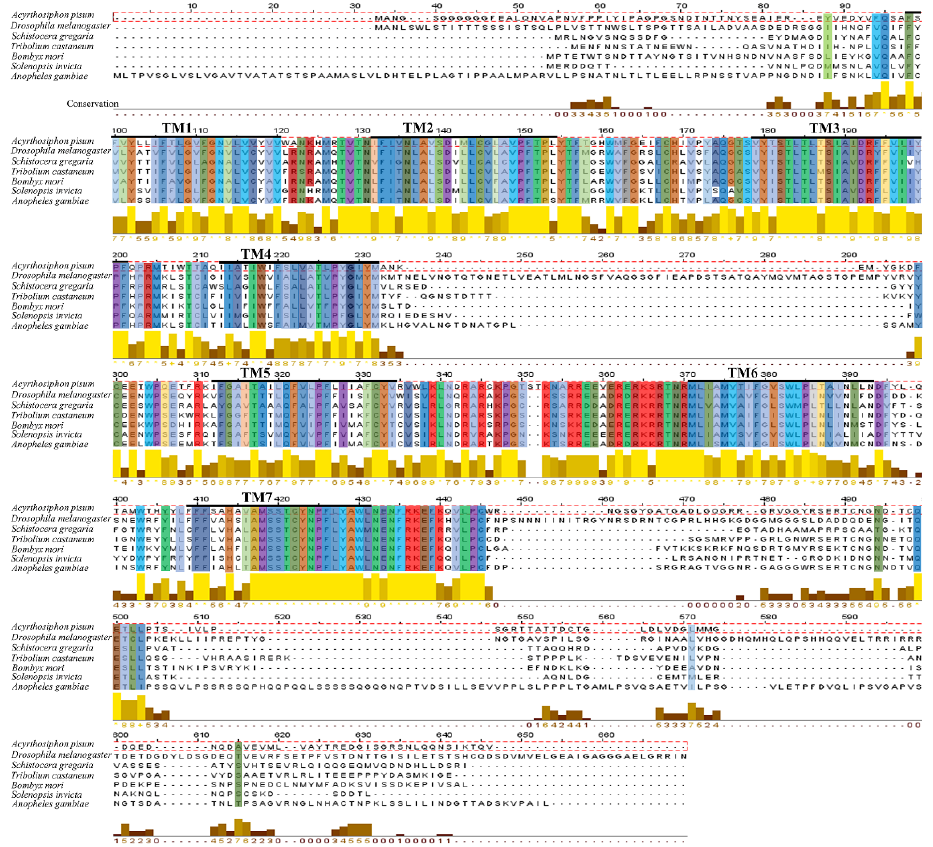
Figure 2. Amino acid multiple sequence alignment of ApsNPFR with sNPFR from other insects ( Drosophila melanogaster , Schistocerca gregaria , Tribolium castaneum , Bombyx mori , Solenopsis invicta , and Anopheles gambiae . The degree of similarity is indicated by the height of yellow or brown bars below the sequences. Transmembrane domains are indicated by black horizontal bars (with numbers at the top;